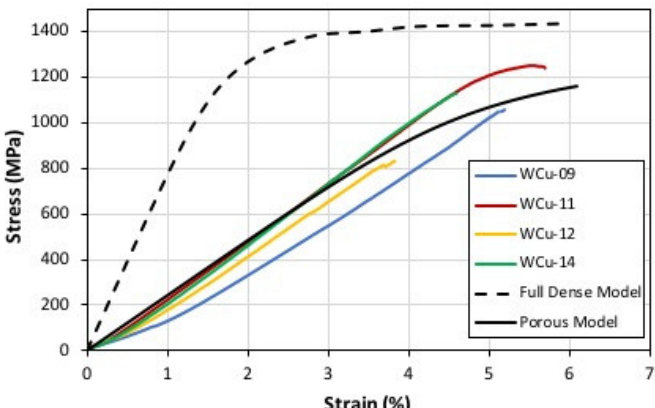
Figure 11. Comparison of the experimental results of W-Cu specimens with the full dense and porous numerical results.